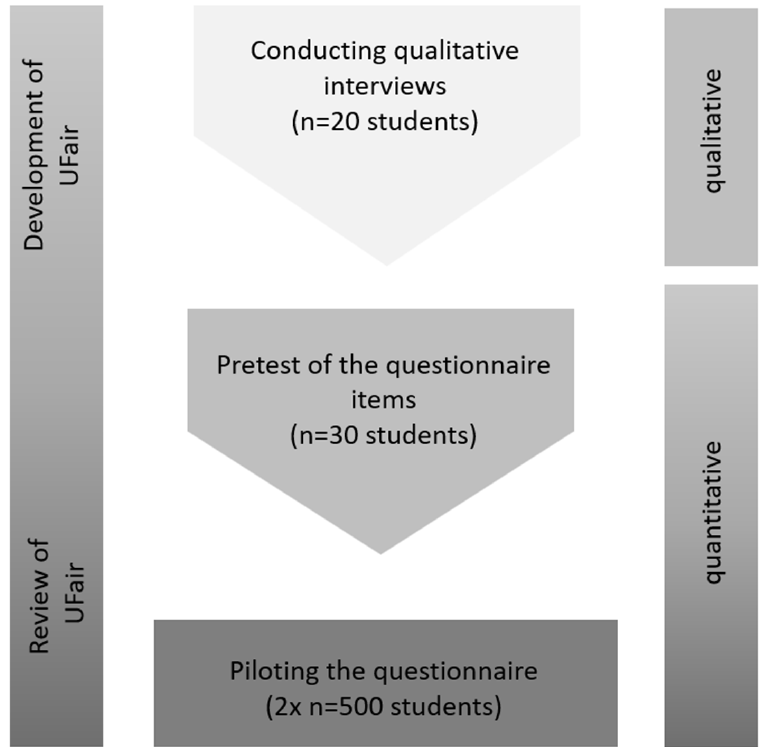
Figure 1. Outline of the study course.